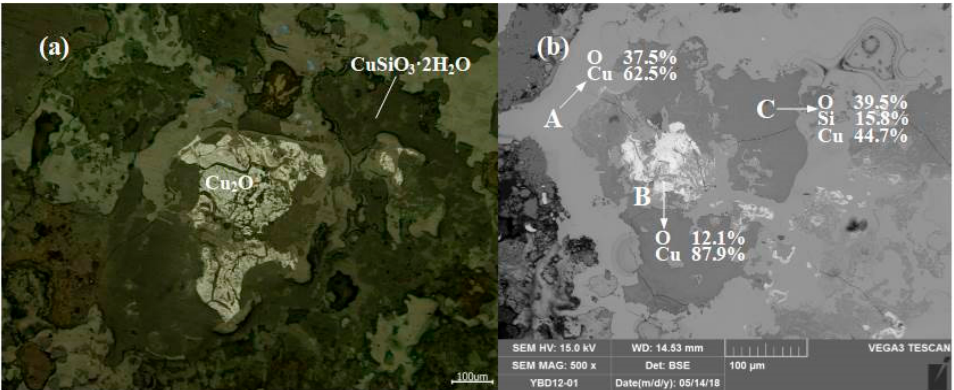
Figure 10. Optical micrograph ( a ) and SEM backsca tt ered electron image ( b ) of YBD13. Sample YBD19: The main component was copper oxide mineral. Among the detected phases, Cu 2 O (cuprite) had the highest copper content and the boundaries between di ff er- ent phases were smooth. As shown in Figure 11.